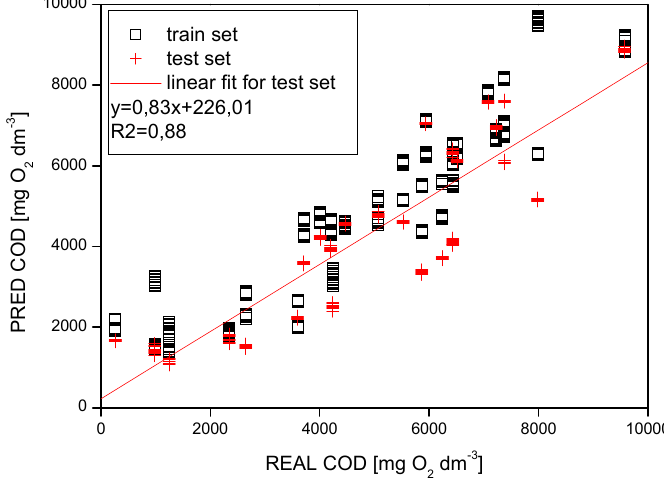
Figure 3. PLS prediction of Chemical Oxygen Demand (COD) in methane fermentation media. The prediction was based on the analysis of sensor array responses obtained from modular flow-through cell ET (Copyright Elsevier B.V.) [29].